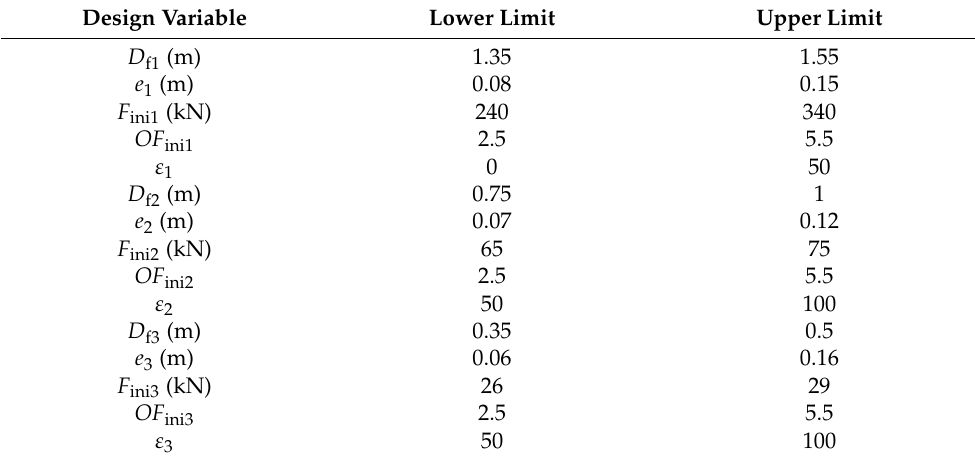
Table 3. The range of design variables of LV